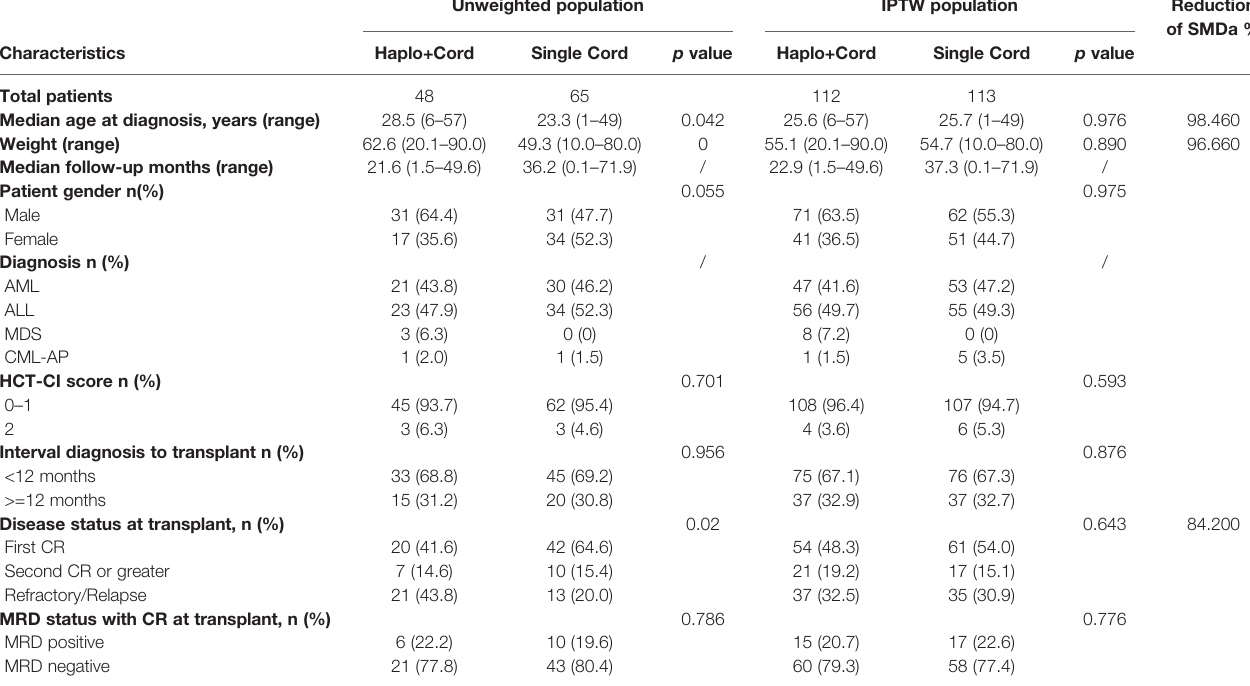
TABLE 1 | Patient baseline characteristics of haplo-cord and single cord group.